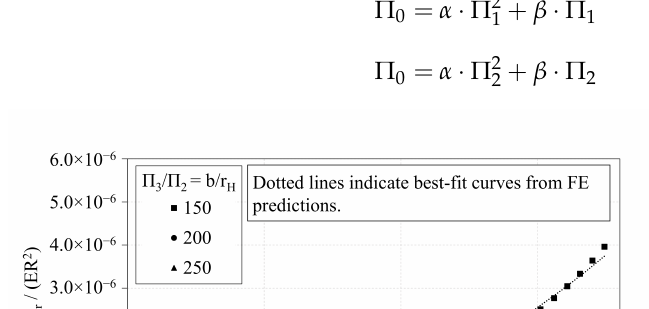
Figure 6. OLC Π 0 vs. Π 1 [26].